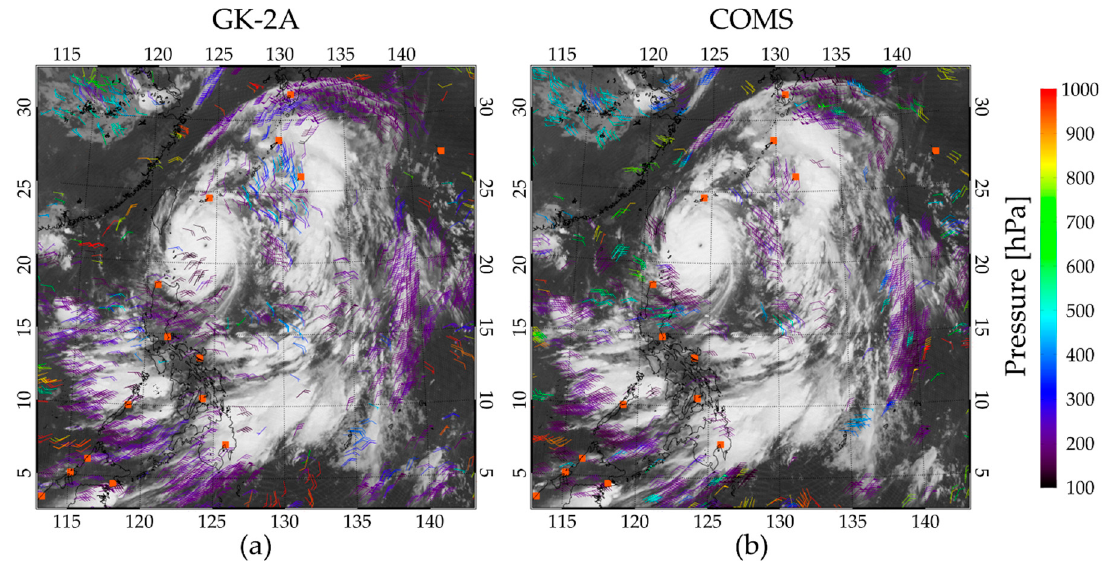
Figure 6. Plots of ( a ) GK-2A and ( b ) COMS AMVs in Typhoon Nepartak at 00:00 UTC on 7 July 2016. Colors represent pressure altitude of AMVs. The background plot is the CH13 (10.2 µ m) brightness temperature of AHI. The orange square symbols represent the stations of rawinsonde captured at the same period. GK2A AMVs survived approximately 64.7% more than COMS AMVs after quality control, considering QIF > 80. Moreover, GK-2A AMVs were more consistent with GDAPS and rawinsonde than COMS AMVs. The specific figures are presented in Table 4. Table 4. Comparisons of validation scores of GK-2A and COMS AMVs with GDAPS and rawinsonde for the specific case of the typhoon Nepartak at 00:00 UTC on 7 July 2016, considering QIF > 80. GK- 2A AMVs are approximately 64.7% more and 18.9% better than COMS AMV during this severe weather. The numbers in parentheses of GK-2A AMVs represent the amount of difference compared to those of COMS AMVs. GK-2A COMS GDAPS Sonde GDAPS Sonde Number 1654 (+44.8%)